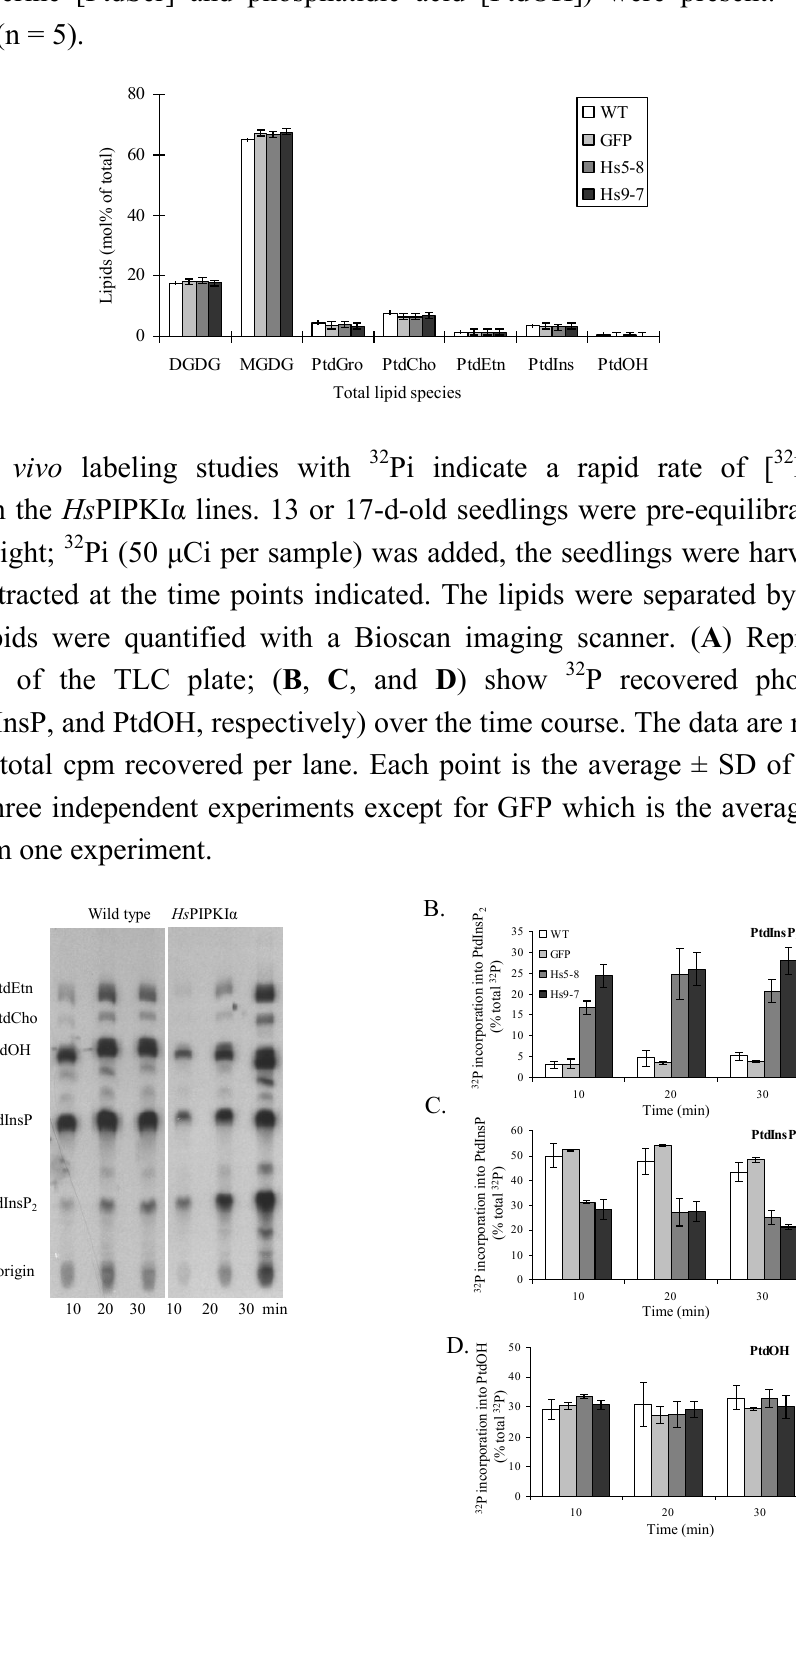
Figure 4. Polar lipid classes (mol % of total polar glycerolipids analyzed) in 3 week-old seedlings from wild-type, GFP and HsPIPKIα lines. The major phospholipid classes (phosphatidylcholine [PtdCho], phosphatidylethanolamine [PtdEtn], phosphatidylglycerol [PtdGro], and phosphatidylinositol [PtdIns]), galactolipid classes (monogalactosyldiacylglycerol [MGDG] and digalactosyldiacylglycerol [DGDG]), and minor phospholipid classes (phosphatidylserine [PtdSer] and phosphatidic acid [PtdOH]) were present. Values are average ± SD (n = 5).